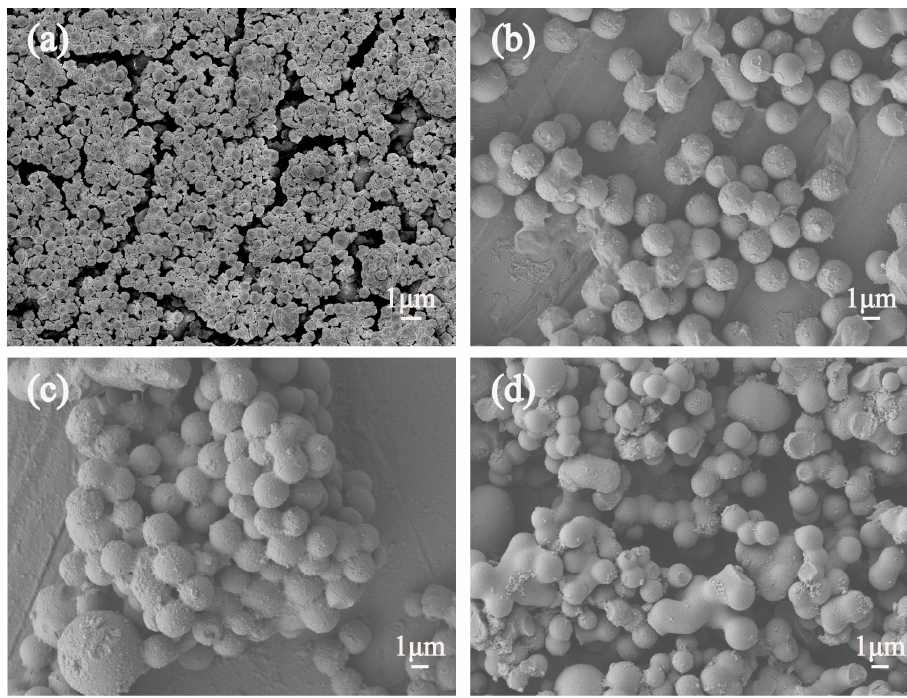
Figure 1. Scanning electron microscope ( SEM) images of carbon spheres (Cs) with different temperatures ( a ) 160 °C ( b ) 180 °C ( c ) 200 °C ( d ) 220 °C.